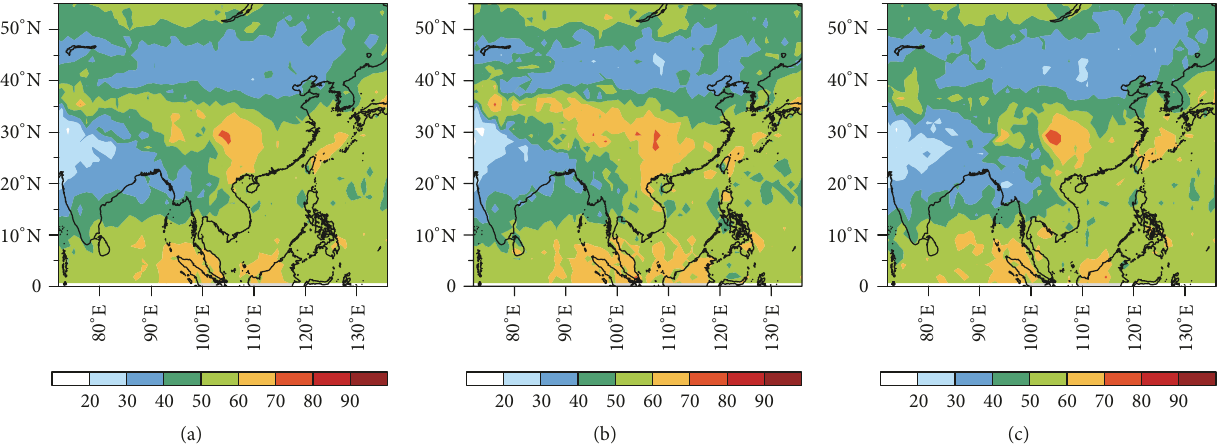
Figure 3: Horizontal distribution of the occurrence of single-layer clouds during (a) the whole day, (b) day-time, and (c) night-time over China and surrounding areas, %.